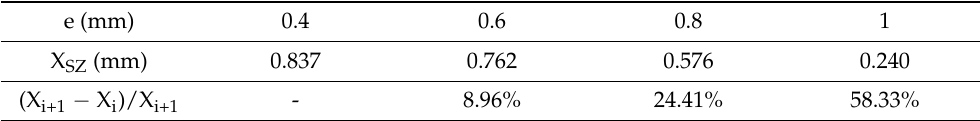
Figure 16. TBH configuration: velocity evolution along the interface. Influence of the PTFE substrate thickness (t = 1 s, θ = 90 ◦ , V 0 = 1 mm 3 , T h = 50 ◦ C, Φ = 3 mW). Table 3. Evolution of stagnation zone with substrate thickness (t = 1 s, θ = 90 ◦ , V 0 = 1 mm 3 , T h = 50 ◦ C, Φ = 3